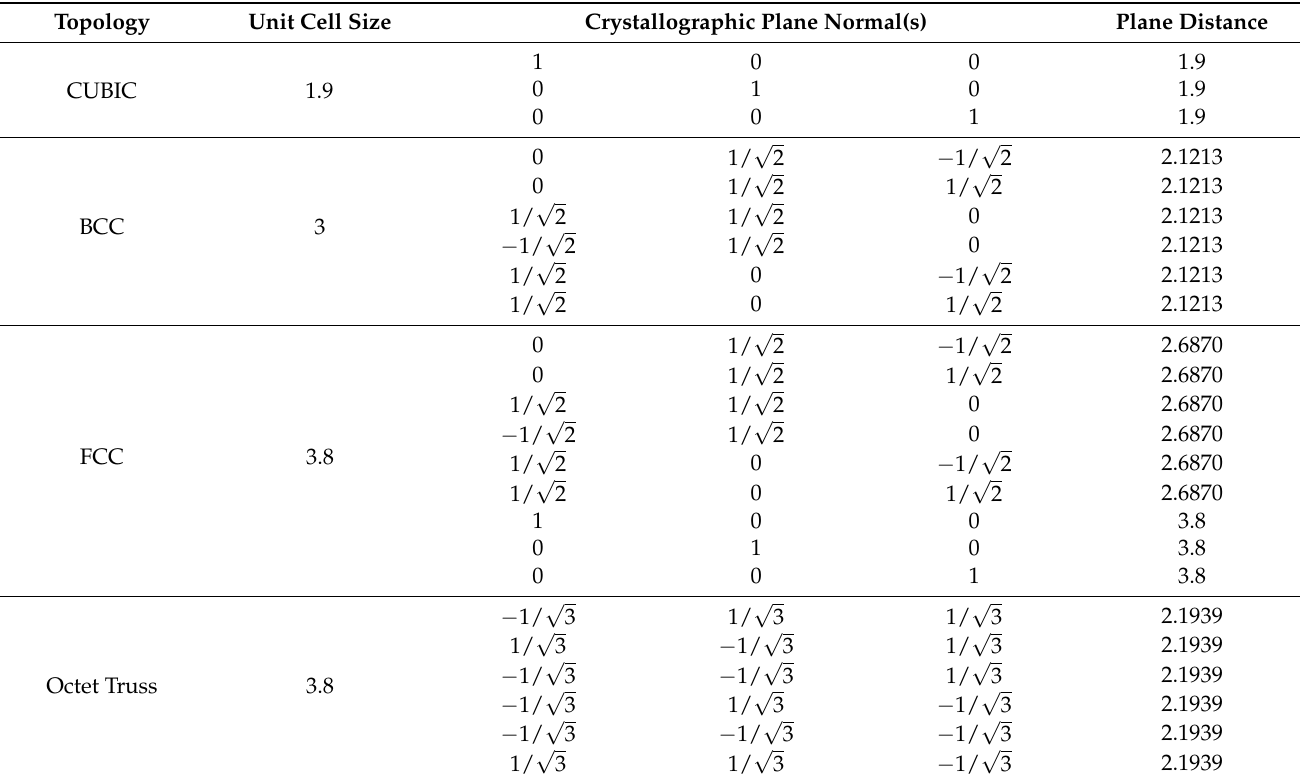
Table 1. Lattice net settings for selected topologies.